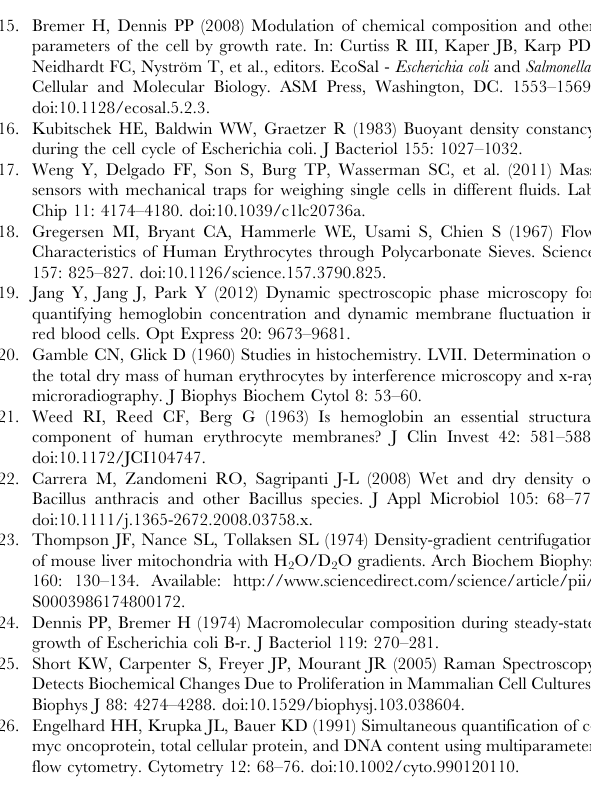
same density and that density is the median observed dry density (vertical line). Figure S5 Dry density distributions for budded and unbudded yeast cells, by timepoint. P-values are for two-sided Mann- Whitney U tests. Figure S6 Contour plots of dry density estimates when the buoyant mass measurements aren’t made in pure H 2 O or pure D 2 O. Intracellular water fractions are in fraction of total volume. Dashed line shows equal departure (in density) from pure fluids. Pure H 2 O and 9:1 (v/v) D 2 O:H 2 O densities are the red dot in the lower left corner of each figure, at which point the dry density is calculated correctly. As salts (or other impermeable components) are added to the fluid, it becomes more dense and the intracellular water is no longer neutrally buoyant. This introduces systematic error into the dry density measurement, which depends on how much of the cell is water. The measurements we’ve made using 1 6 PBS in both fluids are shown as black dots. Figure S7 Time between measurements (exposure time) versus calculated dry density for single cells in each of nine analyses of E. coli samples (2–3 technical replicates for each of 4 samples). Assuming the cell was nearly immediately immersed in D 2 O after the first measurement, this should be a good approximation of time spent in D 2 O. Line shows ordinary least squares fits, which agreed well with robust fits (Huber weights). Correlations are all statistically insignificant at a = 0.05 ( a = 0.006 for each test, using Bonferroni correction). P-values are given for slope being non-zero using one-sided t-test.